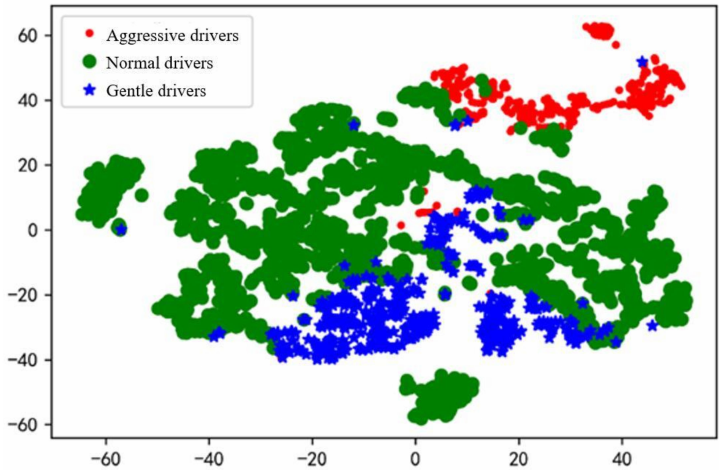
Figure 6. Driver category after K-means clustering.